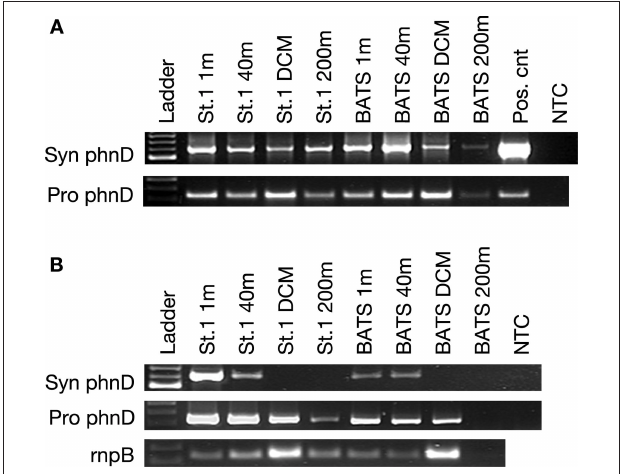
FIgure 3 | (A) PCR of Synechococcus and Prochlorococcus spp. phnD from the Sargasso Sea samples taken in at Station 1 and BATS (Station 2) during October 2008. The mixed layer was 50 m, and the DCM was at 100 m. (B) Top rows: RT-PCR of environmental RNA extracted from the same stations. (B) Bottom: RT-PCR of picocyanobacterial rnpB transcripts as a positive control for picocyanobacterial RNA. NTC, no template